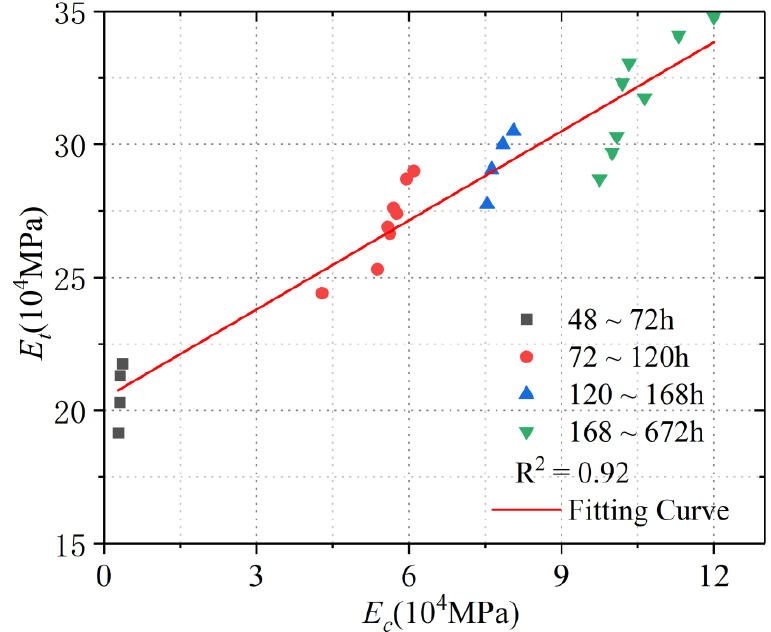
Figure 7. Fitting curve of elastic modulus of a micro-matrix around the capillary ( 𝐸 𝑡 ) and static elastic modulus ( 𝐸 𝑐 ).